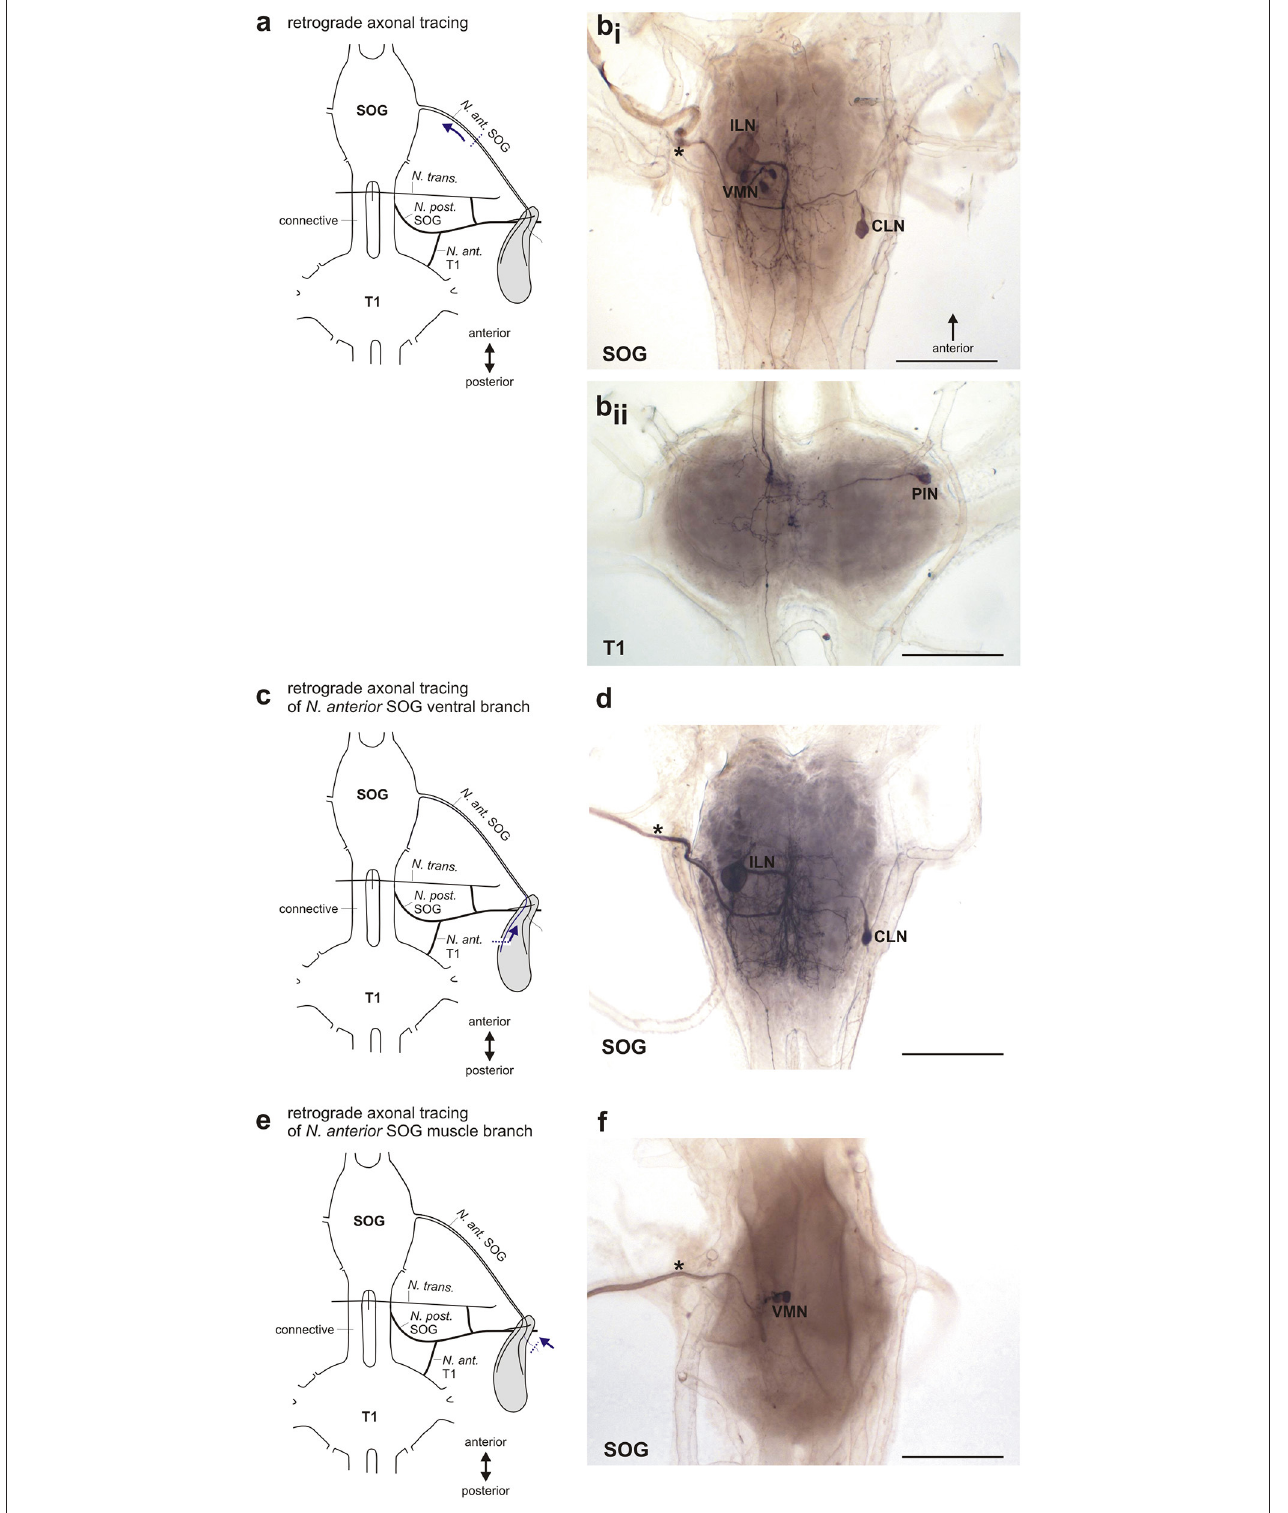
FIGURE 7 | Retrograde axonal tracing of the N. anterior SOG. (a) Schematic for the retrograde tracing of N. ant. SOG toward the central nervous system. Dotted line indicates cut site of the nerve, arrow indicates the direction of axonal tracing. (b) Stained neuron types after retrograde tracing of N. ant. SOG in the